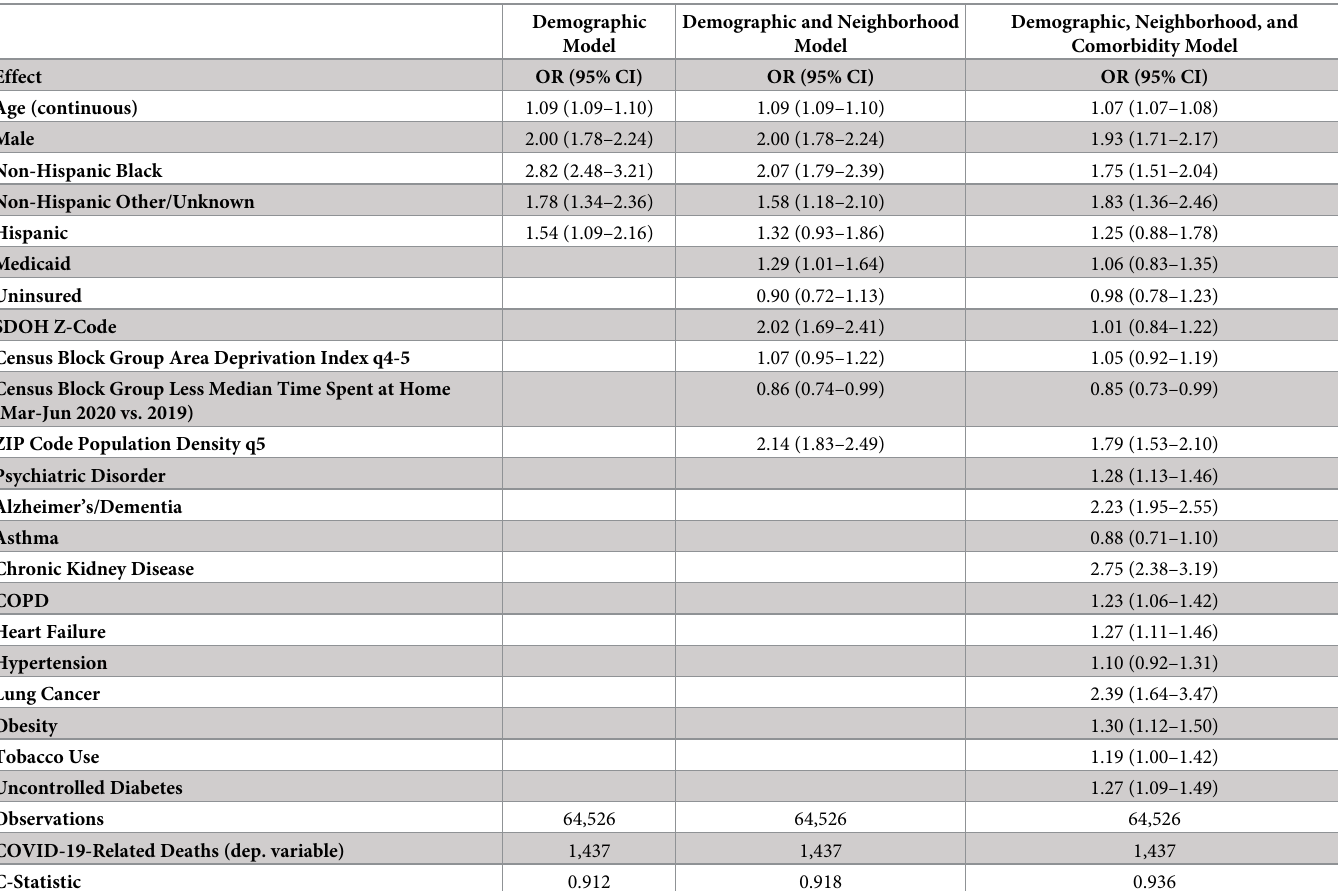
Table 2. Logistic regression models for